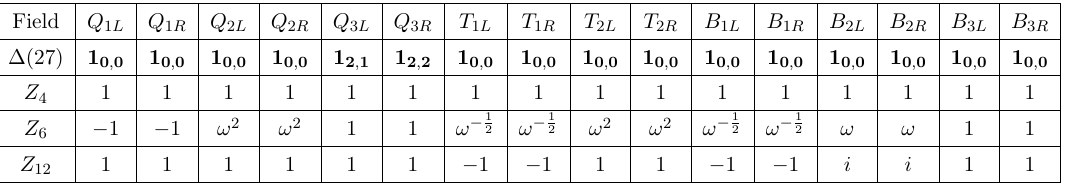
Table 2 . Transformation properties of the quarks under the (cid:13)avor symmetry (cid:1) (27) Field